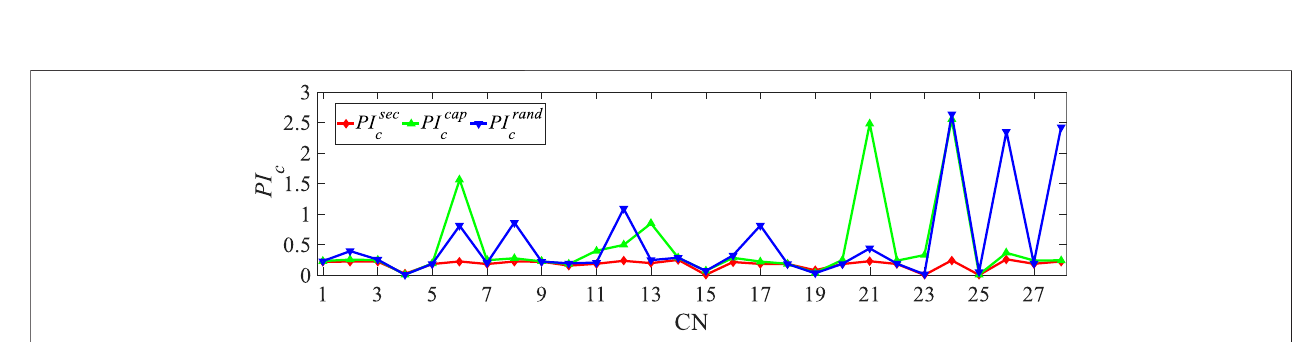
FIGURE 14 | The PI c values obtained with different IL unit prices.